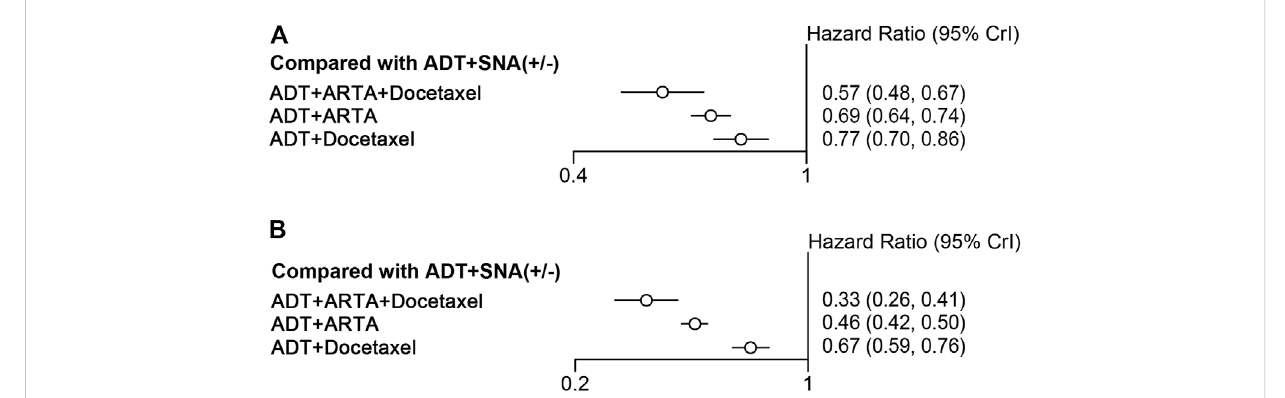
FIGURE 3 Comparison of categorized therapies for ef fi cacies. (A) Forest plot representing HR for improving OS for combination therapy compared with ADT with or without SNA. (B) Forest plot representing HR for improving rPFS for combination therapy compared with ADT with or without SNA. OS, overall survival; ADT, androgen deprivation therapy; SNA, standard non-steroidal antiandrogen; rPFS, radiographic progression-free survival; HR, hazard